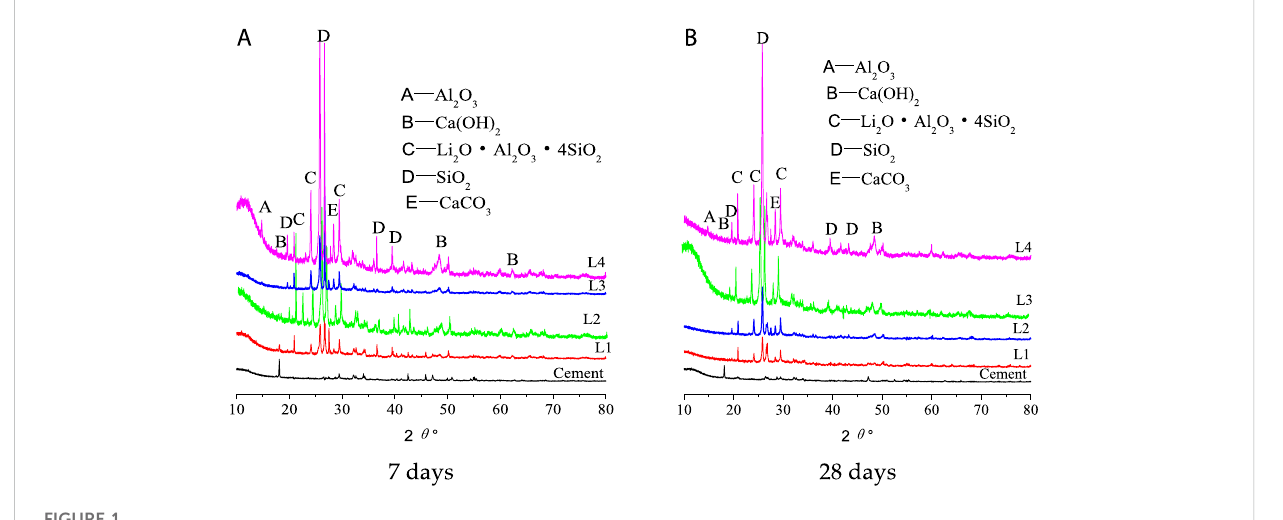
FIGURE 1 XRD spectrum of cement paste and cement – lithium slag